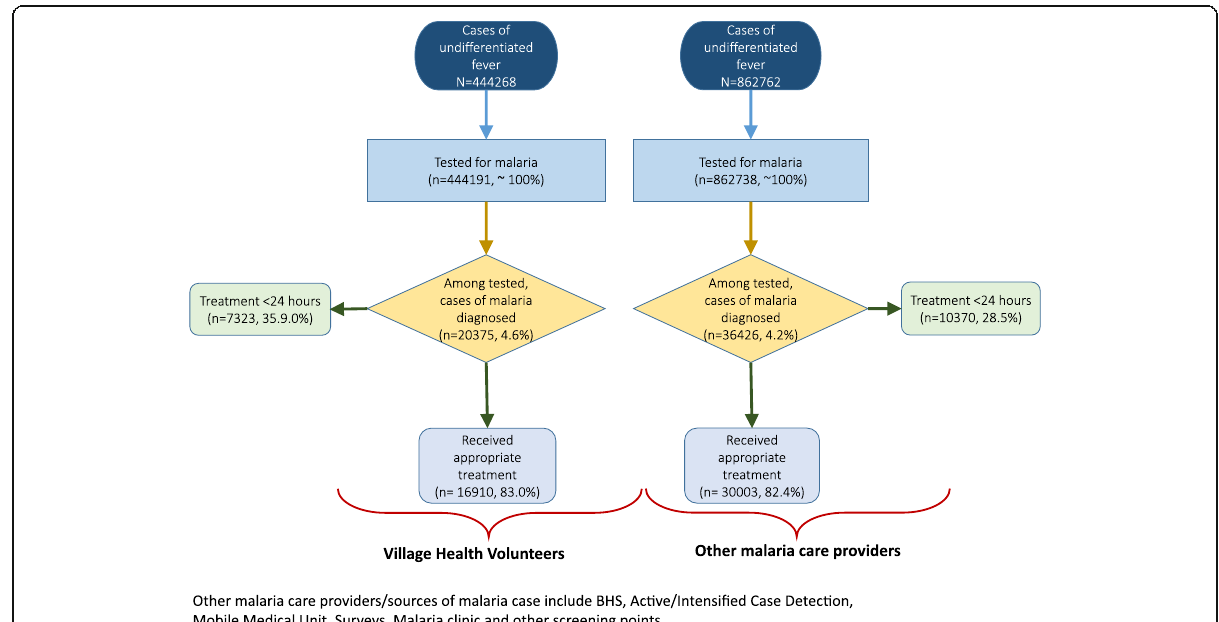
Fig. 3 Flowchart comparing the cascade of care (testing, diagnosis, and treatment) by village health volunteers and other malaria care providers under NMCP in Myanmar,